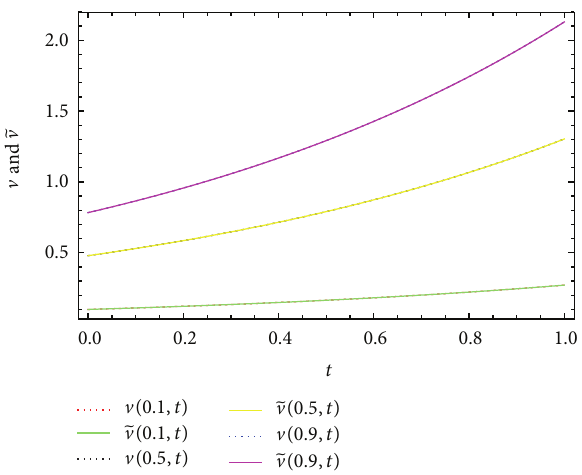
Figure 18: The approximate ̃ V and the exact V solutions for different values of 𝑦 = 0.0 , 0.5, and 0.9 of problem (55), where 𝑁 = 10 and 𝛼 = 𝛽 = 1/2 in the interval [0,1]